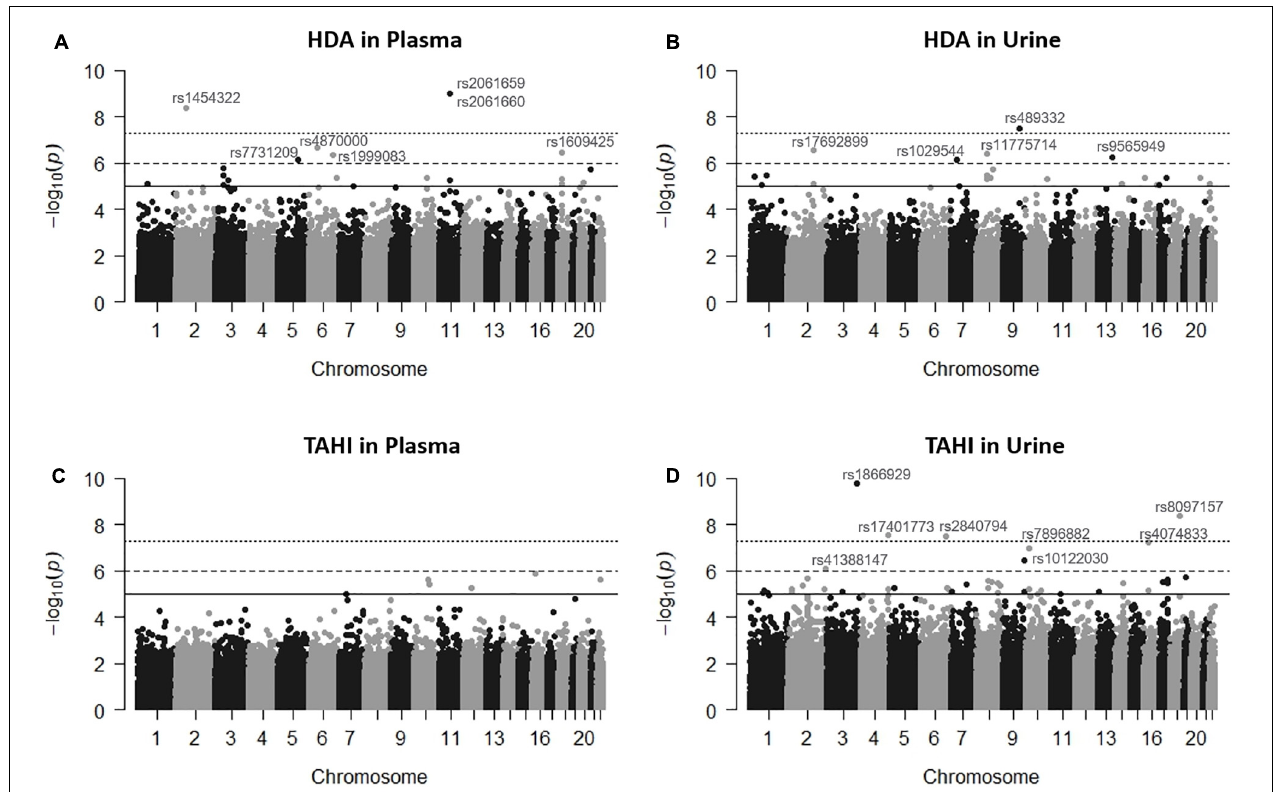
FIGURE 1 | Manhattan plots showing the single-nucleotide polymorphisms (SNPs) significantly associated with 1,6-diaminohexane (HDA) in plasma (A) and urine (B) and trisaminohexyl isocyanurate (TAHI) biomarker levels in plasma (C) and urine (D) when inhalation and skin exposures to 1,6-hexamethylene diisocyanate (HDI) monomer and HDI isocyanurate were used as covariates, respectively. Urine biomarker levels were adjusted with creatinine level. The solid line is the suggestive significance default line at -log 10 ( p =1 × 10 − 5 ), the dashed line is equivalent to false discovery rate (FDR) = 0.10 at − log 10 ( p = 1 × 10 − 6 ), and the top dotted line is the genome-wide significance default line at − log 10 ( p = 5 × 10 − 8